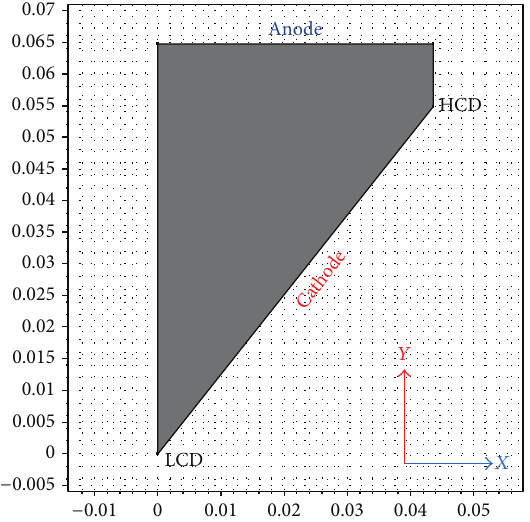
Figure 3: Geometry of the modified Hull